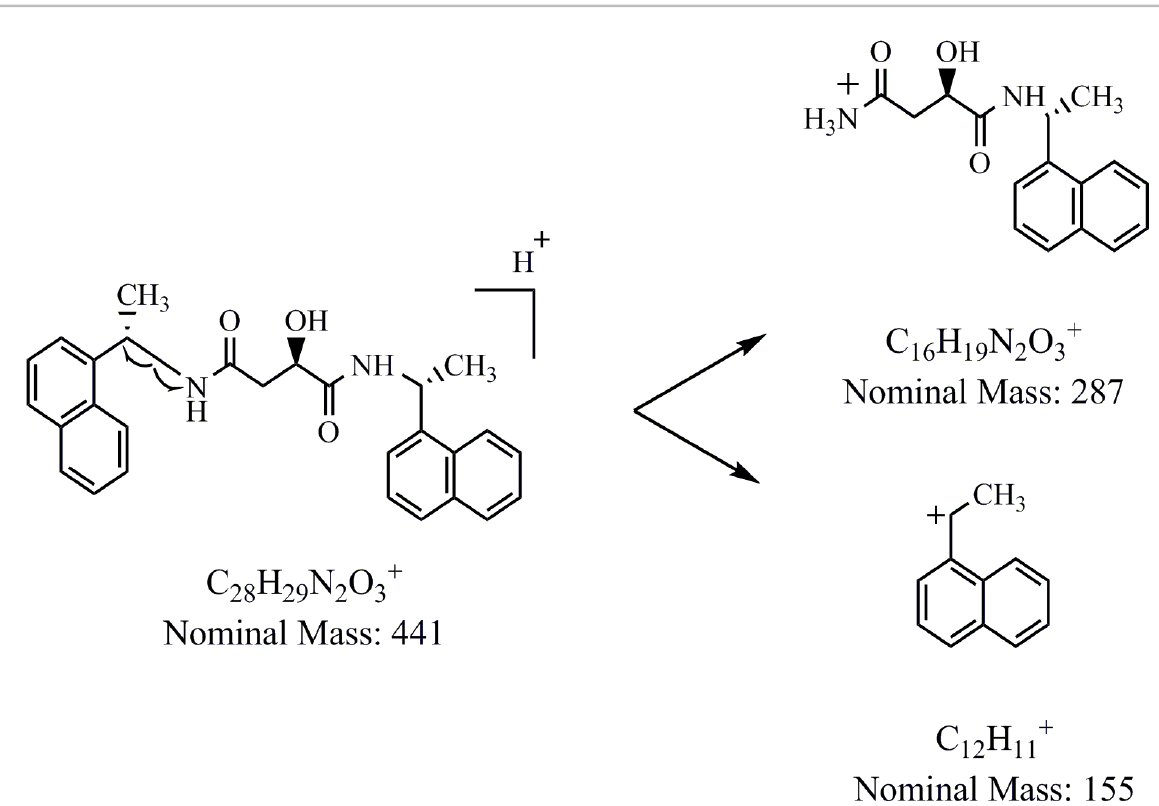
FIGURE 4 - Proposed fragment pathway for derivatives of malic